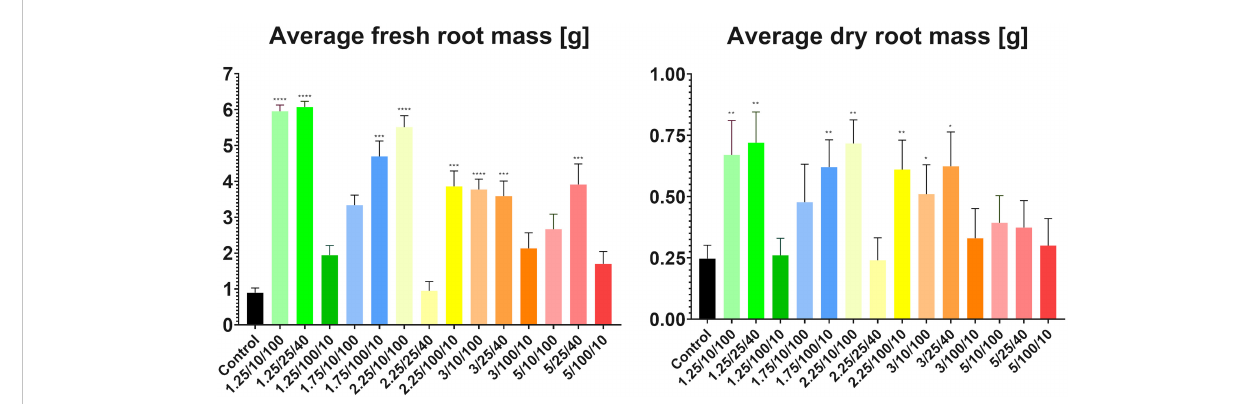
FIGURE 4 Measurements of average fresh and dried root masses per plant. Asterisks highlight groups showing the most statistically signi fi cant differences in weight in comparison to controls (**** = P<0.0001 and decreases in their number correlate to an increase in P value) found after conducting Student ’ s t-test. Parameters shown on the X-axis are presented in the following order: E/t/N.